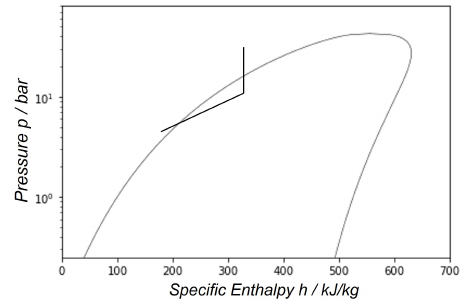
Figure 7. P-h diagram of the behaviour of the fluid inside the capillary tube when the adiabatic stretch length is longer than the single-phase length, in the case where the fluid returns to subcooled liquid conditions once it enters the two-phase